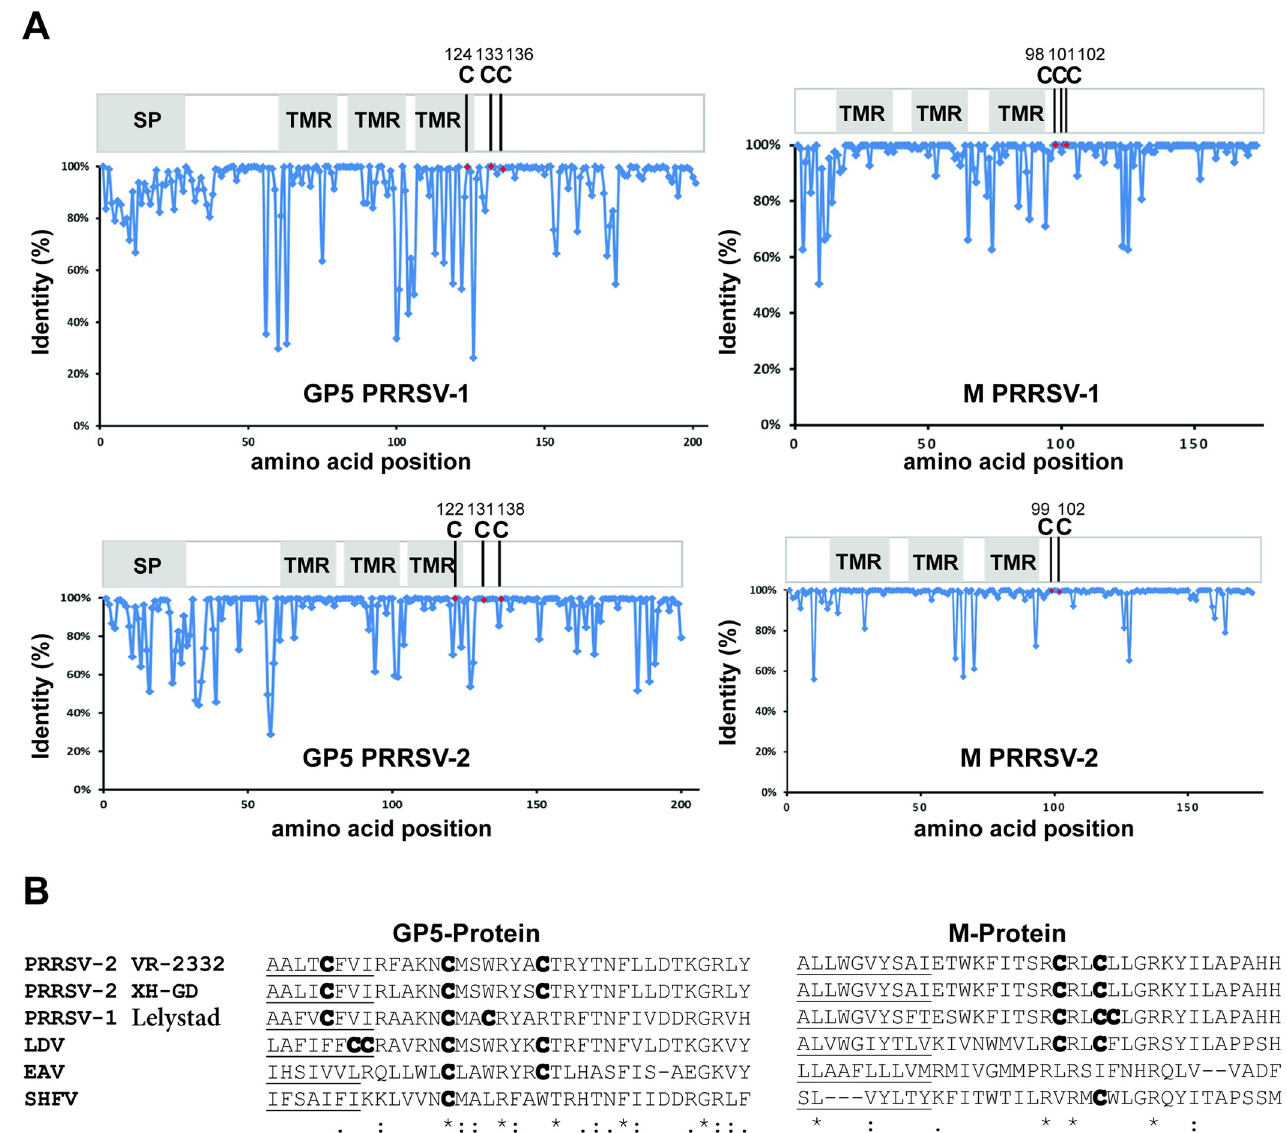
Fig 1. Conservation of cysteine residues in the cytoplasmic tail of GP5 and M. (A) The graphs show the percent conservation (y axis) of amino acids at each position (x axis) of a consensus sequence compiled from all M and GP5 sequences of either PRRSV-1 and PRRSV-2 present in the database. The scheme above each graph indicates the location of the signal peptide (SP) and transmembrane region (TMR) within the primary structure of the respective protein. C are the conserved cysteine residues and the number indicates their position in the amino acid sequence. (B): Aligned amino acids sequences of the transmembrane region (TMR, underlined) and the adjacent part of the cytoplasmic tail of GP5 and M of different members of the Arteriviruses. VR-2332: type 2 prototype PRRSV strain, XH-GD: highly pathogenic Chinese PRRSV-2 strain, Lelystad: type 1 prototype PRRSV strain, LDV: lactate dehydrogenase-elevating virus, EAV: equine arteritis virus prototype strain Bucyrus and SHFV: simian haemorrhagic fever virus. Cysteines are marked in bold. Asterisk ( � ): Identical amino acids, colon (:): residues with strongly and period (.): with weakly similar properties.